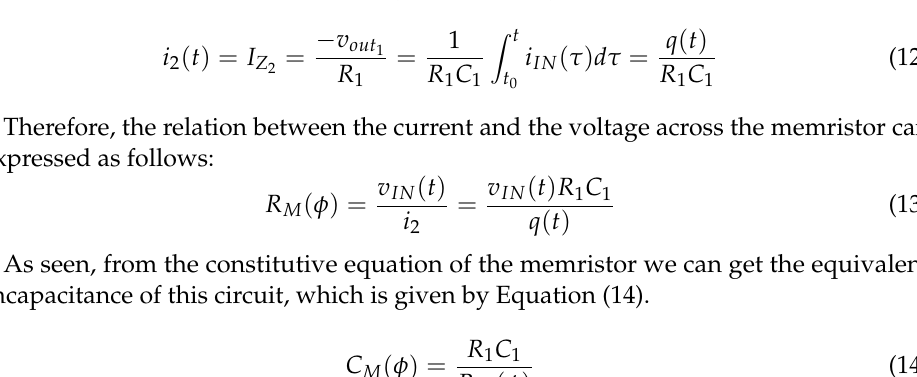
Figure 5. ( a ) Memcapacitor emulator circuit proposed by Wang et al. [44] implemented with a voltage-controlled memristor. ( b ) Memcapacitor emulator schematic using a memristor emulator based on a LED optically coupled to a LDR (light-dependent resistor).